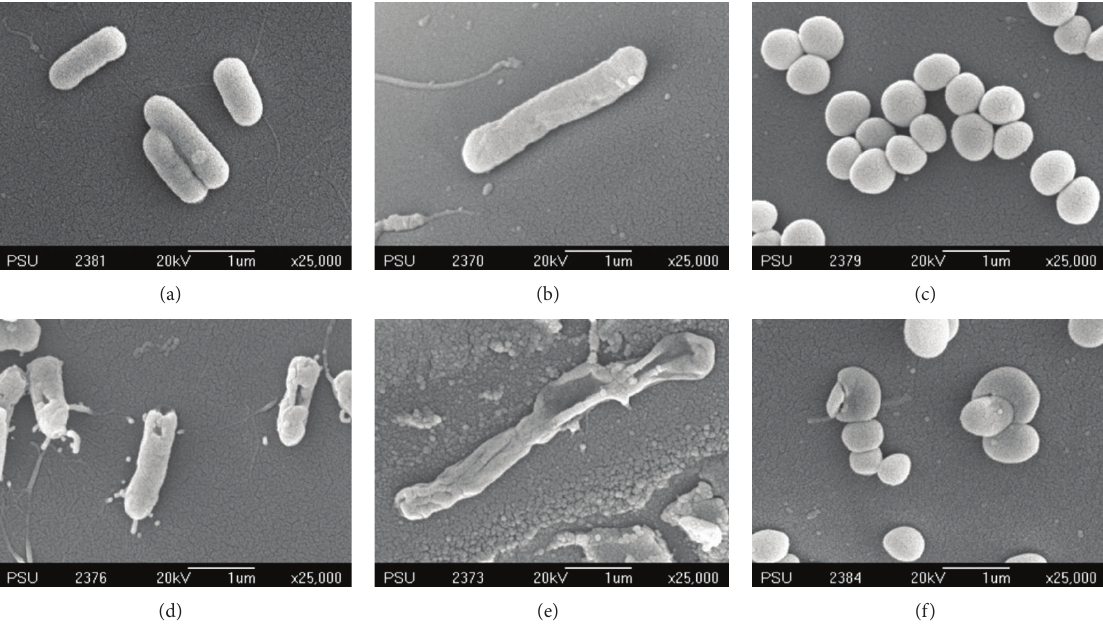
Figure 15: SEM images of bacteria observed on surface coated thin films: (a) untreated ( S. typhi ), (b) untreated ( E. coli ), (c) untreated ( S. aureus ), (d) irradiated for 15 min ( S. typhi ), (e) irradiated for 40 min ( E. coli ), and (f) irradiated for 60 min ( S. aureus ) of 20N/3SnO 2 /TiO 2 composite thin